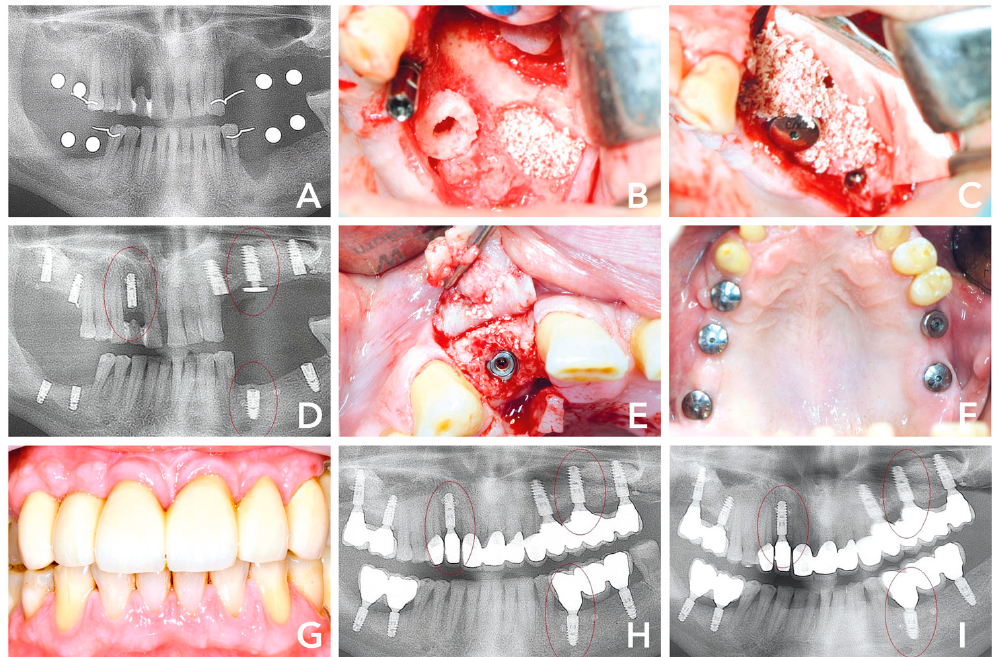
Figure 3. ( A ) Initial situation 6 weeks after extraction of teeth #12, #24-25 and #34. ( B )